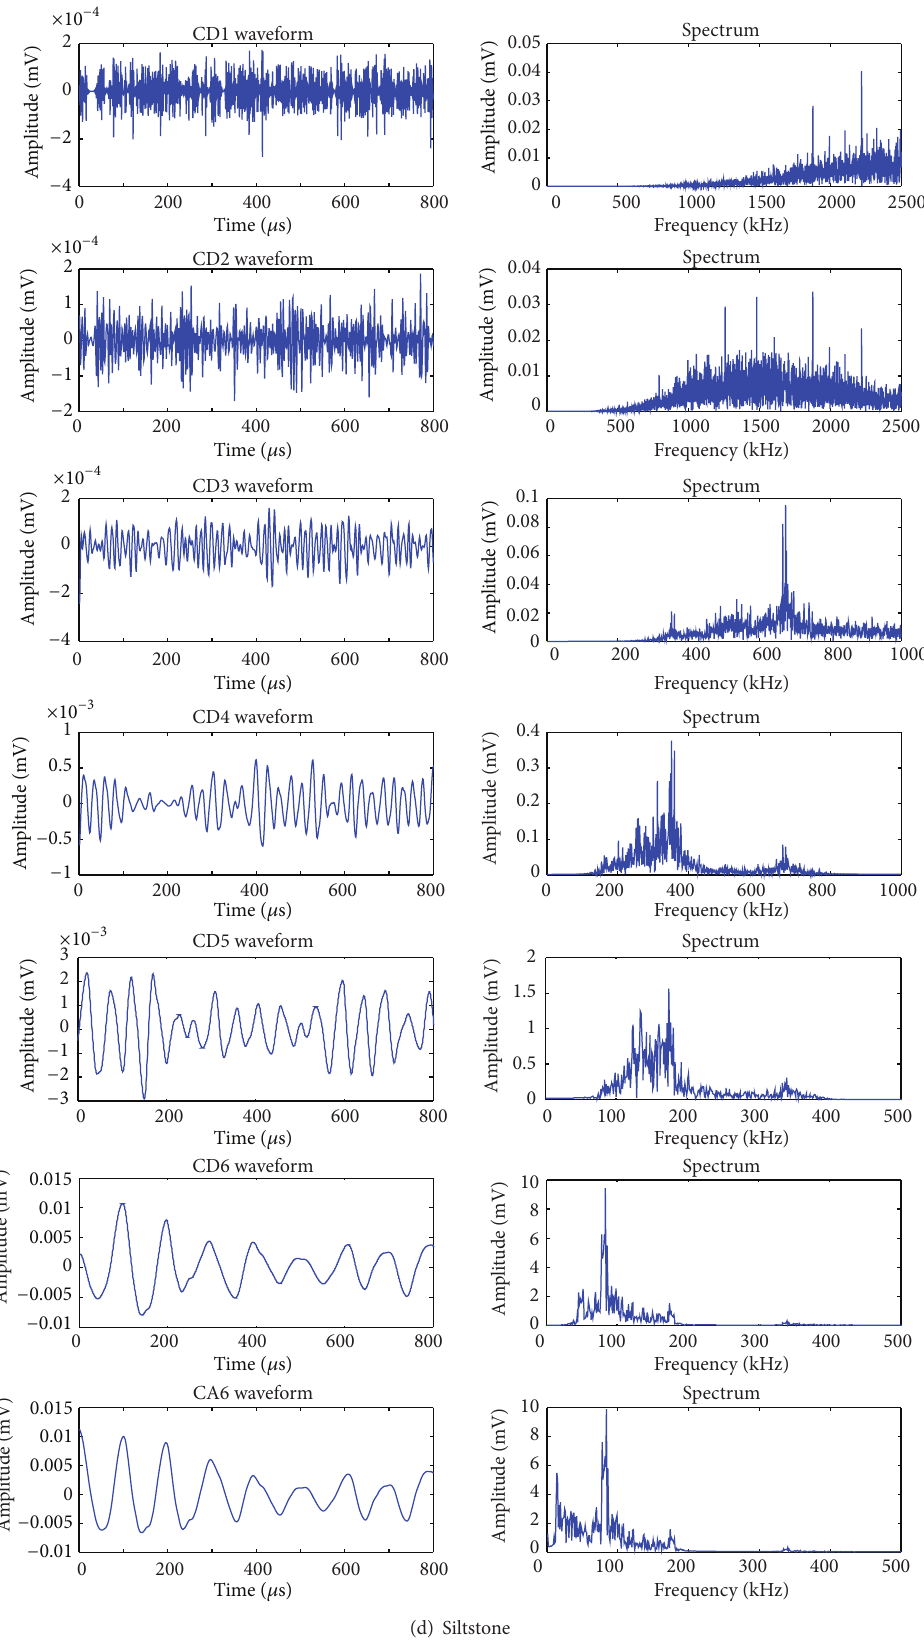
Figure 4: Six layers of the wavelet decomposition for the rock